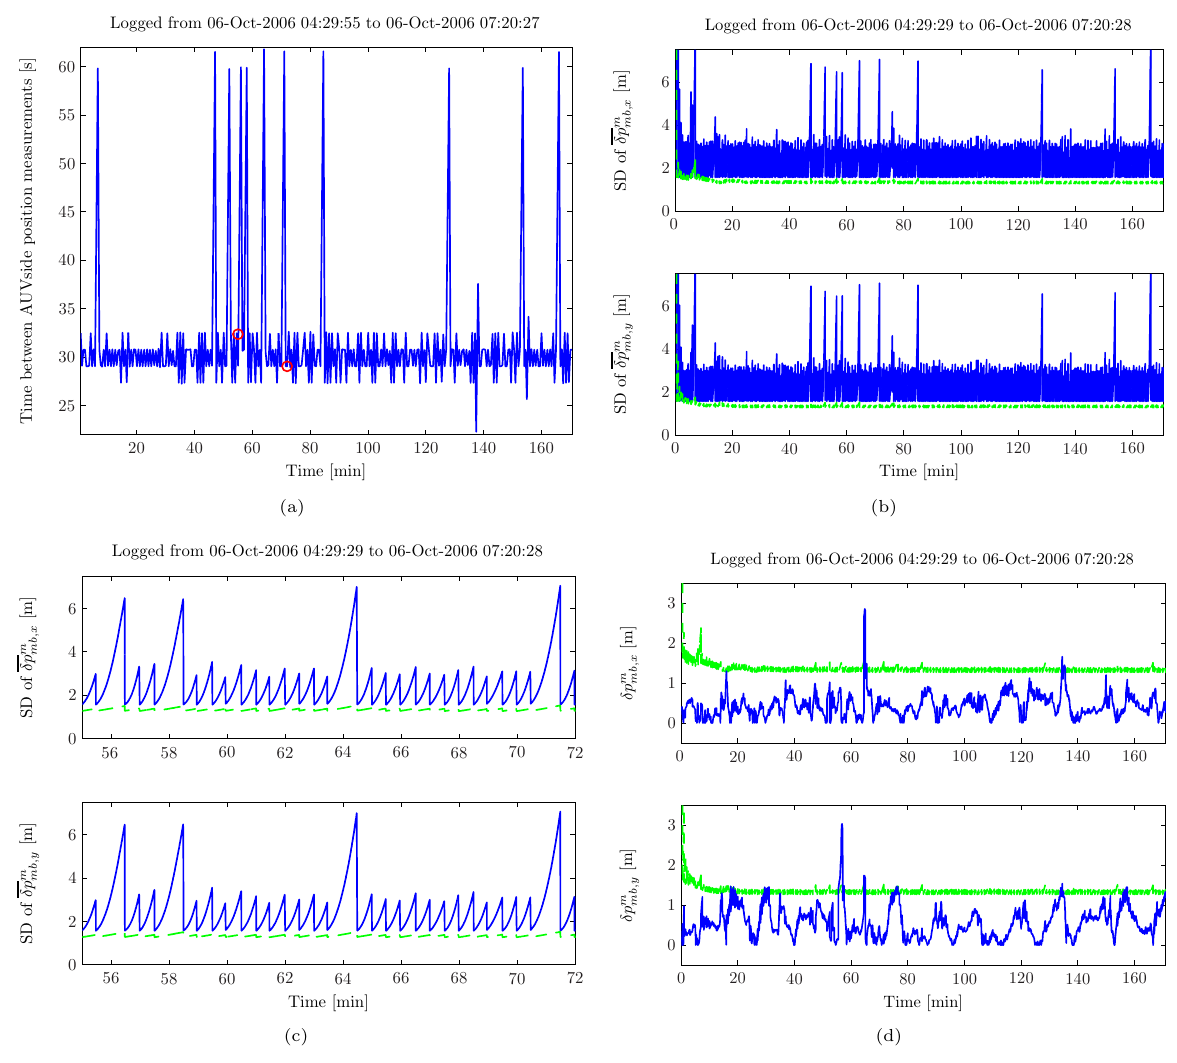
Figure 7: Traditional and model-aided INS evaluated according to case 2: (a) The blue (solid) line shows the time between position measurements, as received by the AUV. The basis trajectory is the same as in Figure 6(a). The circles indicate 54 and 72 minutes into the run. (b) The estimated real-time position uncertainties (1 σ ) for the model-aided INS are shown in green (dashed). The estimated real-time position uncertainties (1 σ ) for the traditional INS are shown in blue (solid). (c) Magnified version of Figure 7(b). The model-aided INS provides smoother estimates than the traditional INS. (d) The estimated real-time position uncertainties (1 σ ) for the model-aided INS are shown in green (dashed). The true position errors (assuming basis is correct) for the model-aided INS in north and east shown in blue